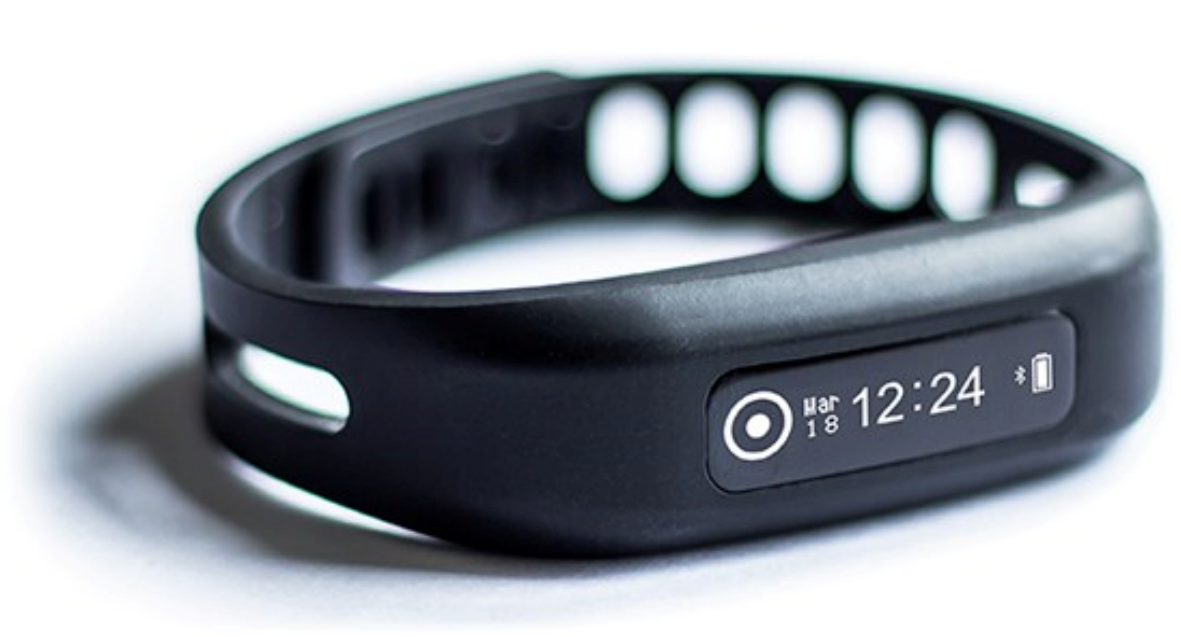
Figure 3. The Neo Health One wristband as the self-tracking device in the